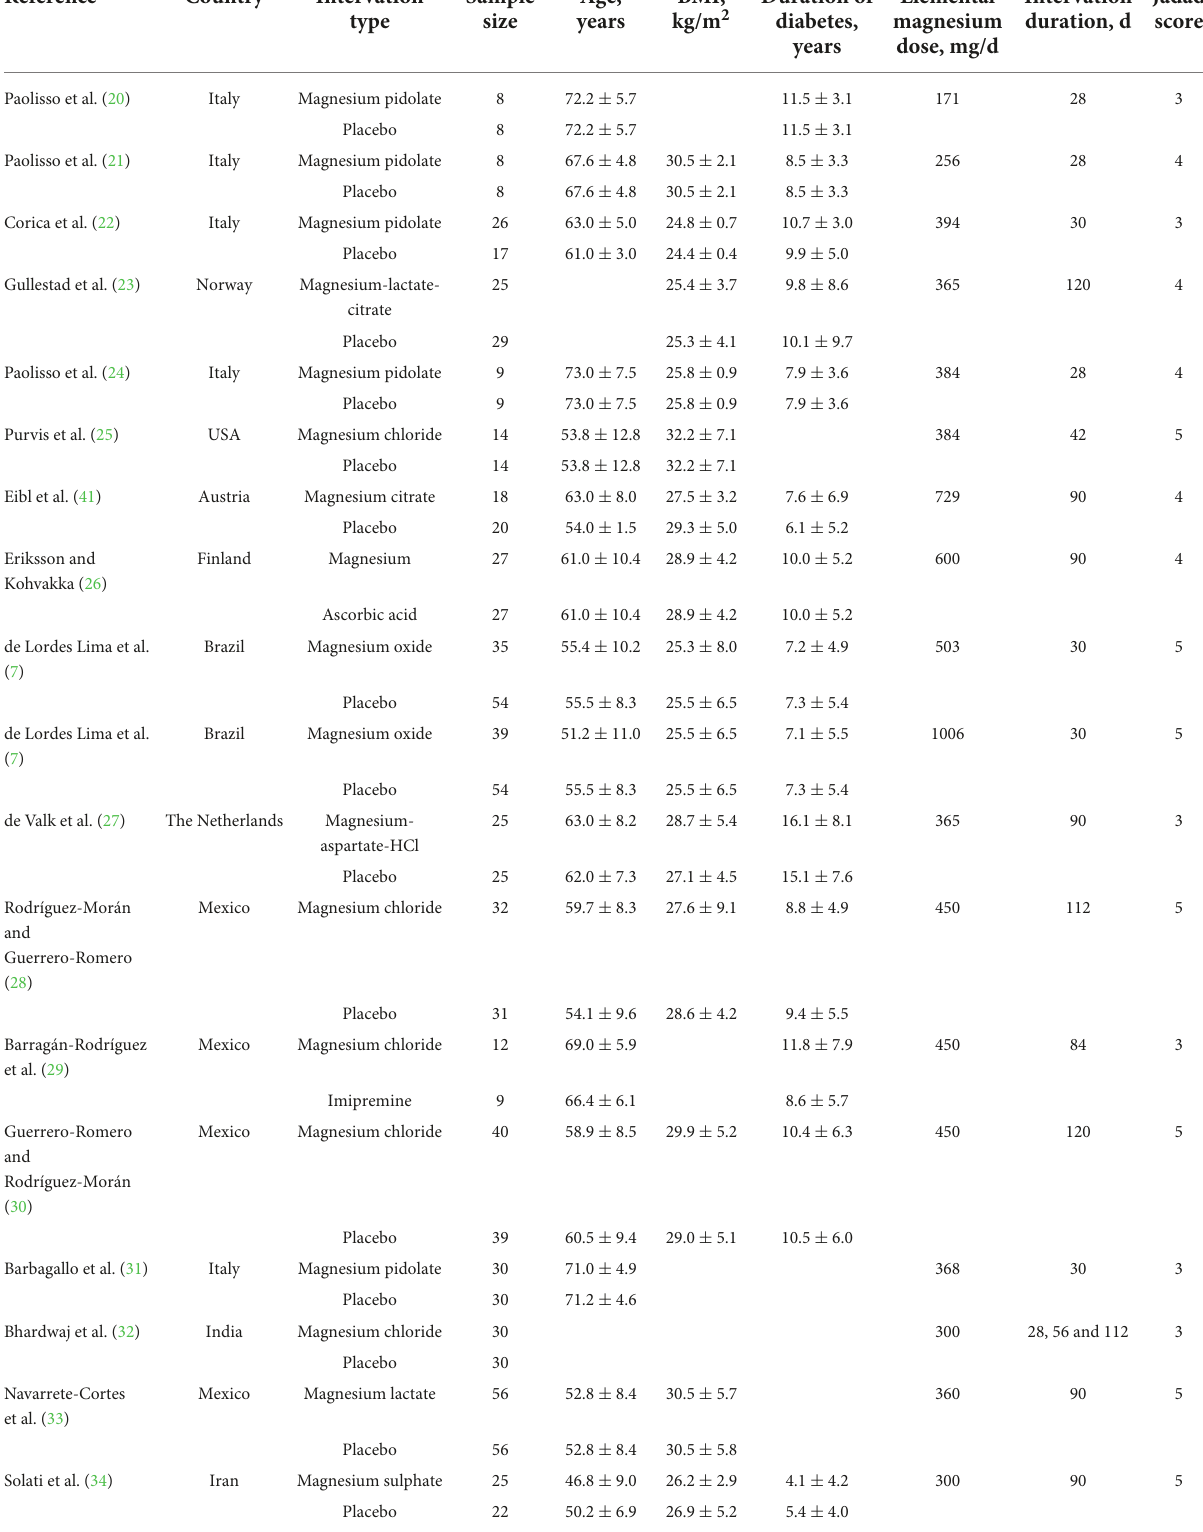
TABLE 1 Characteristics of included studies on magnesium intervention in type 2 diabetes mellitus a